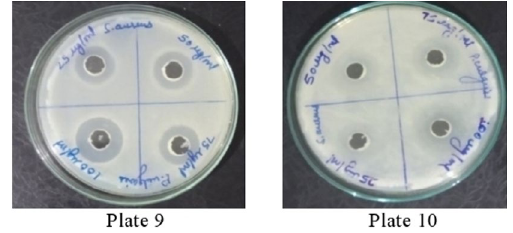
Fig. 8. Plate 9 & 10 Anti-Bacterial Activity of Methanolic Extract of P. vulgaris against S. aureus.